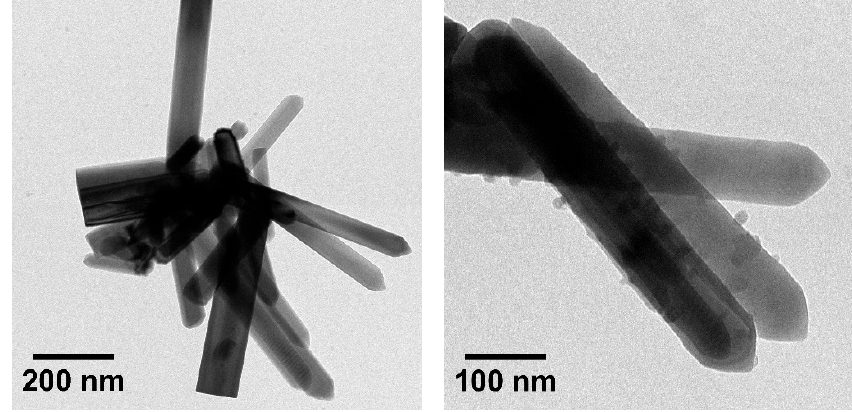
Figure 3. TEM images of ZnO nanorods ( left ) and copper nanoparticles deposited onto ZnO nanorods ( right ).